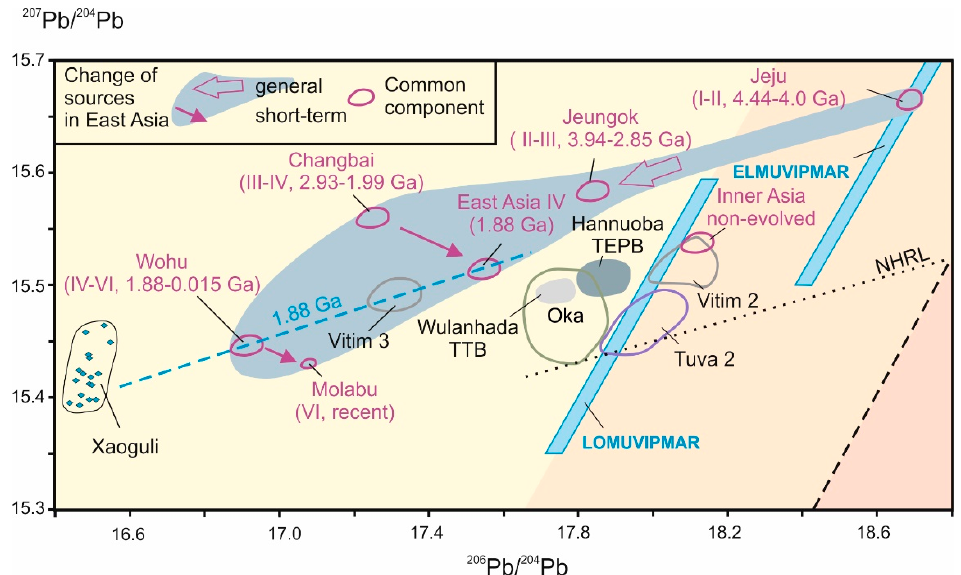
Figure 16. Diagram of 207 Pb/ 204 Pb versus 206 Pb/ 204 Pb for common components and isometric data fields of volcanic rocks from Inner and East Asia. The LOMUVIPMAR and ELMUVIPMAR compositions, as well as the LOMU – ELMU and ELMU limit dividing lines are shown as in Figure 5. Shown are the common components of the Figures 5b, 6c, 8a, 9 and 11b,c and isometric data fields of the Figure 11a,c. A data field of the Xiaoguli volcano is plotted after